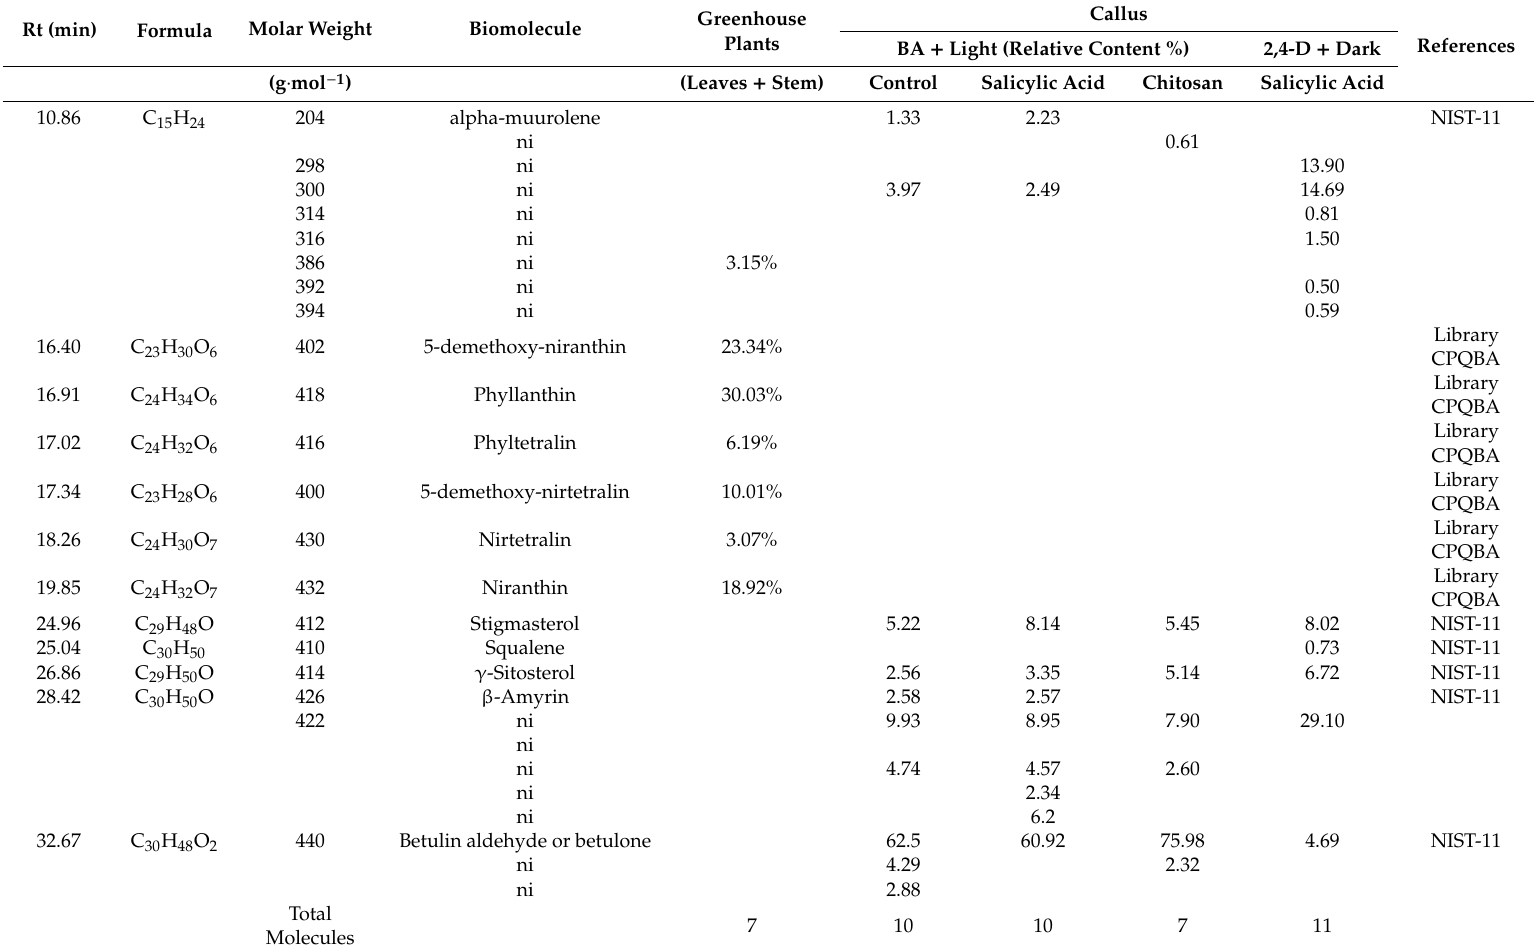
Table 5. Biomolecules biosynthesized by greenhouse plants and in vitro types of calli of Phyllanthus amarus under di ff erent conditions and identified by GC-MS. Callus Greenhouse Rt (min) Formula Molar Weight Biomolecule Plants ReferencesBA + Light (Relative Content %) 2,4-D + Dark (g · mol − 1 ) (Leaves + Stem) Control Salicylic Acid